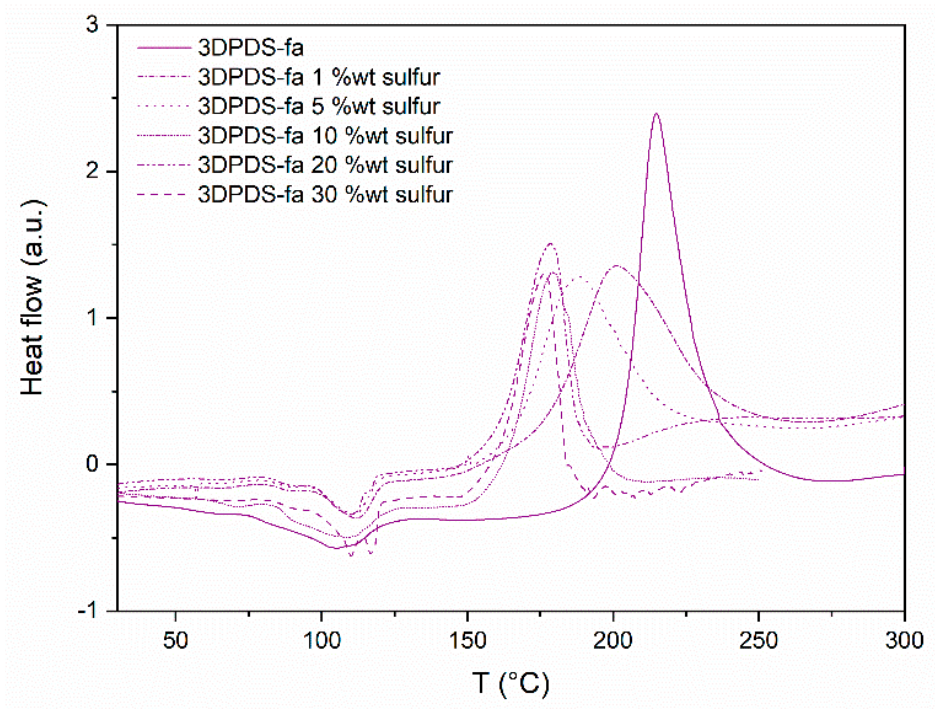
Figure A23. DSC thermogram of 3DPDS-fa, 3DPDS-fa with 1, 5, 10, 20 and 30 %wt of sulfur.